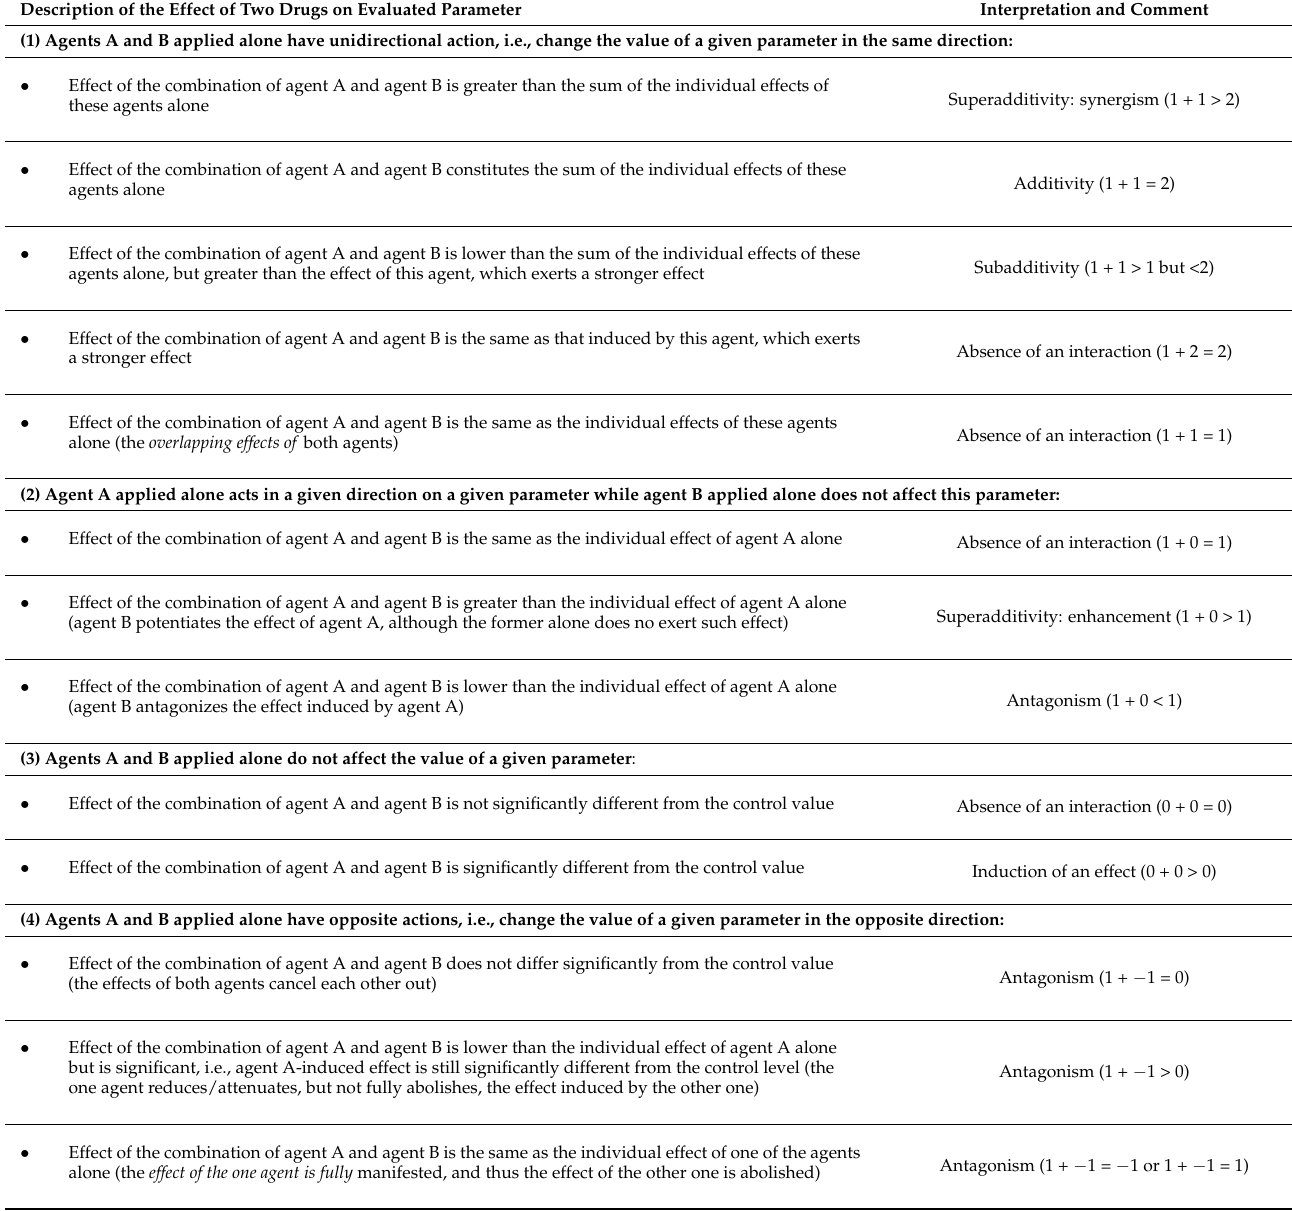
Table 2. Overview table of possible types of interactions in the aspect of the present